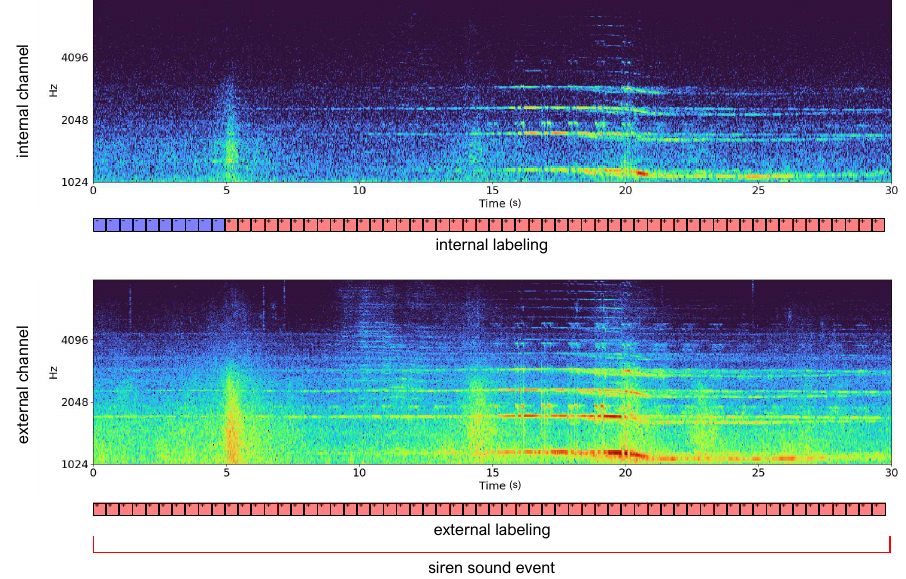
Figure 9. Spectrograms of siren recordings acquired by sensors inside ( top ) and outside ( bottom ) the passenger compartment with different labeling criteria for the internal